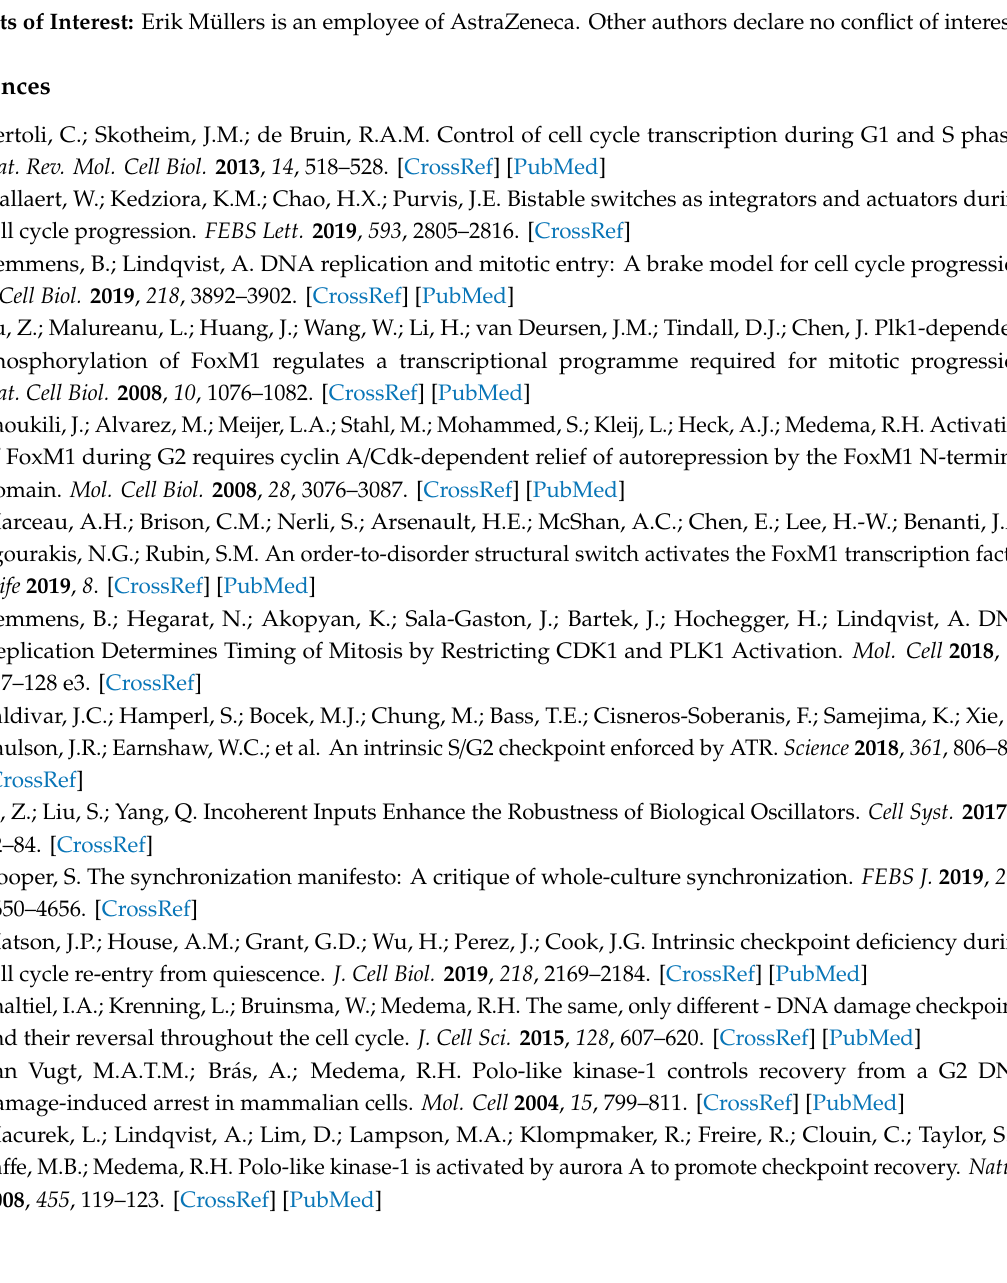
Figure S1: A setup to detect FRET by ratiometric flow cytometry, Figure S2: Characterization of ATAD2 levels through the cell cycle, Figure S3: A setup to investigate checkpoint recovery by FRACS, Figure S4: Quantification of pTCTP versus MPM-2 staining, supplementary data file: data from Mass Spectrometry